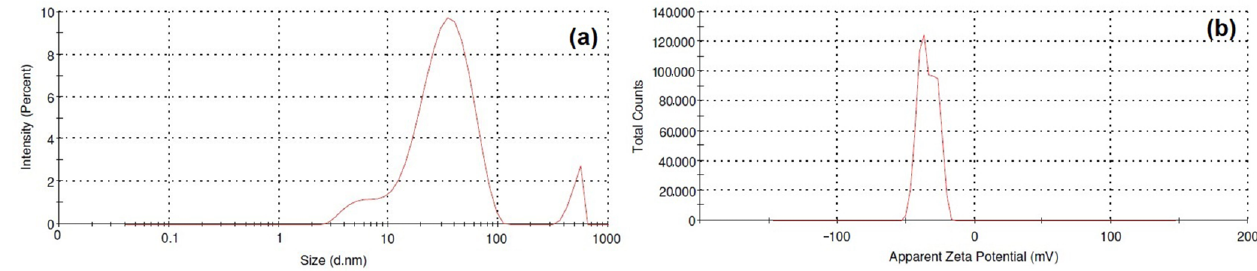
9 of 14 Figure 3. PS of ( a ) CRL-MCs, ( b ) CRL-NCs (gray area indicates the PS distribution), and ( c ) compar- ative graphical representation of both CRL-MC and -NCs. 3.6. PS, PDI and ZP